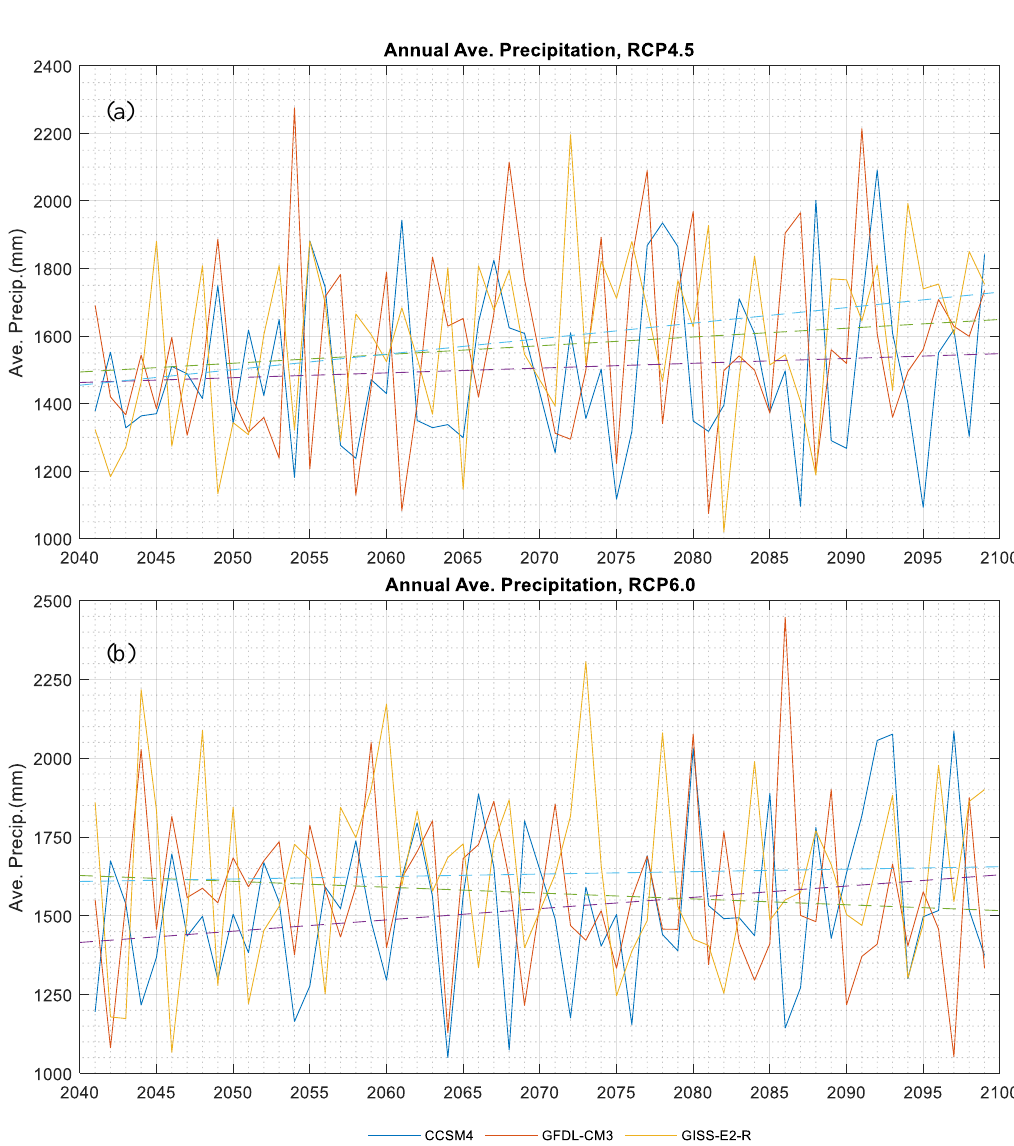
Figure7. Annualprecipitationbasedonthemodelsandundersevere( a )andmoderate( b Figure 7. Annual precipitation based on the models and under severe ( a ) and moderate ( b ) emission scenarios.